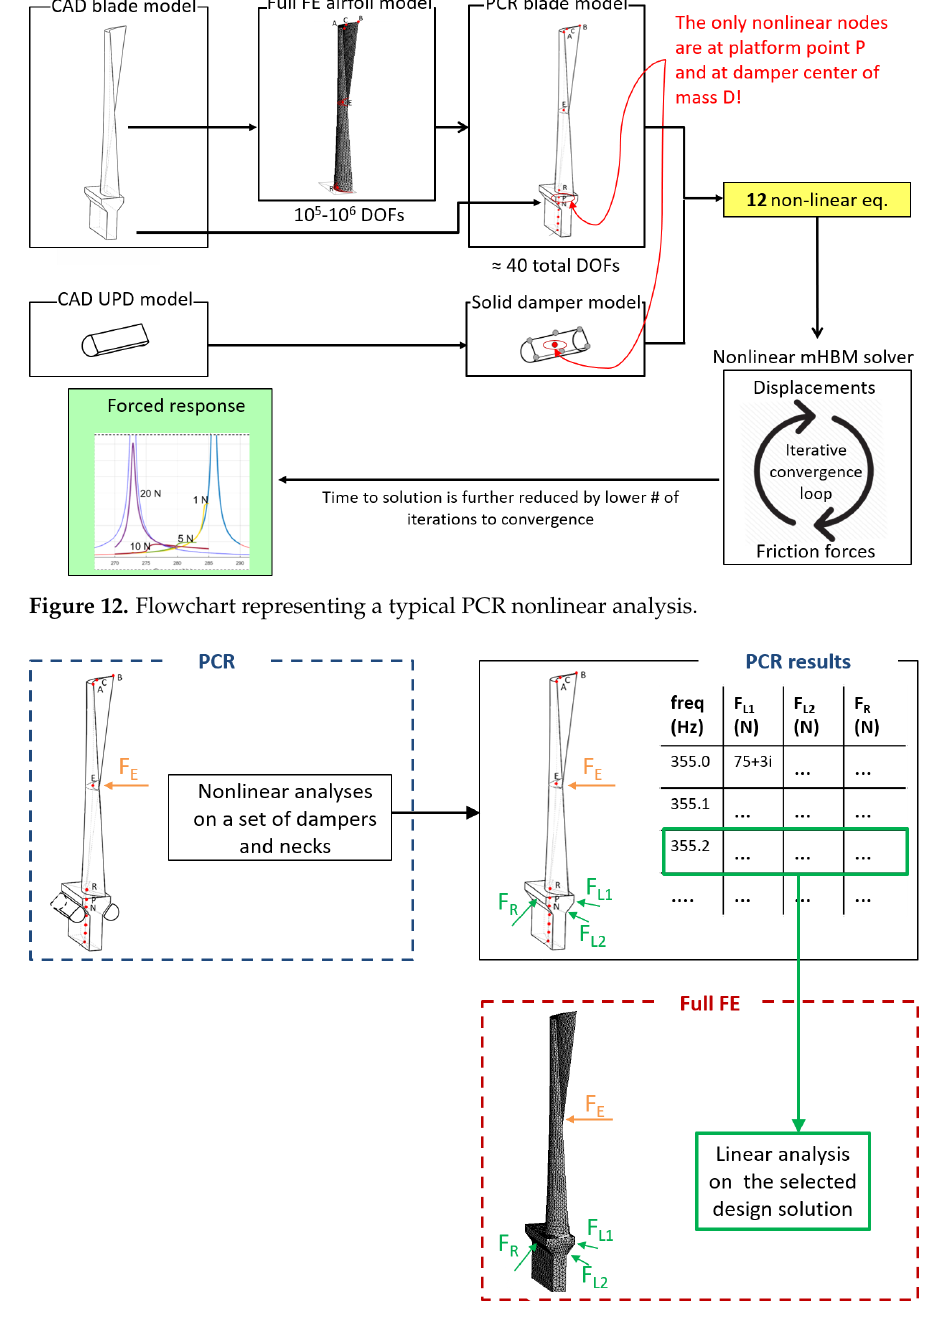
Figure 13. Flowchart representing the role of the PCR reduction in a typical design